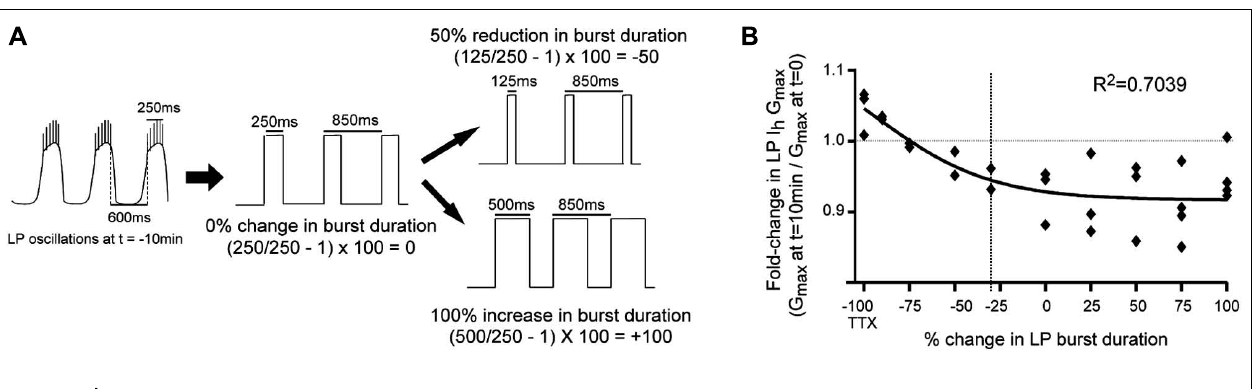
change in cycle period. (B) Plot of fold-changes in LP I h G max for the 10 min time point; − 100 on the x -axis represents experiments in TTX without a recurring step; vertical dashed line marks 30% reduction in burst duration (i.e., average 5 μ M DA-induced change) each diamond represents one experiment; data were fitted with a Boltzmann sigmoidal